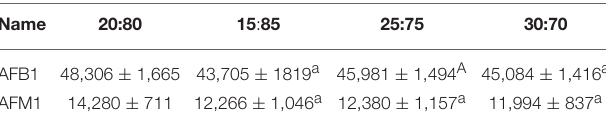
TABLE 3 | Effects of mobile phase [acetonitrile:water (v/v)] on peak area of AFB1 and